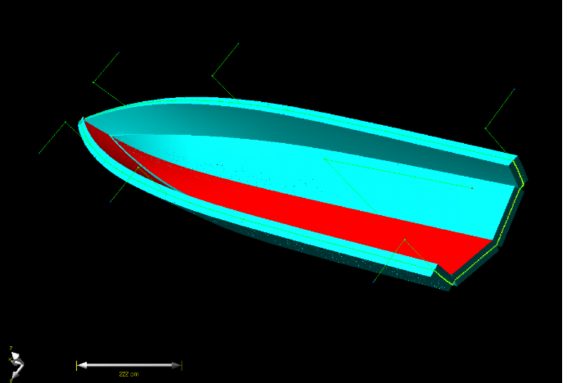
Figure 9. Modeling of hull structure for resin flow